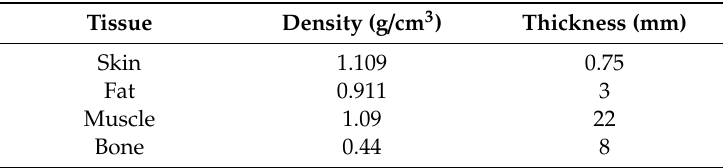
Figure 7. ( a ) Simulation of the distribution through the human tissue. ( b ) Changes in SPL through the human tissue. Table 2. Density and thickness of di ff erent